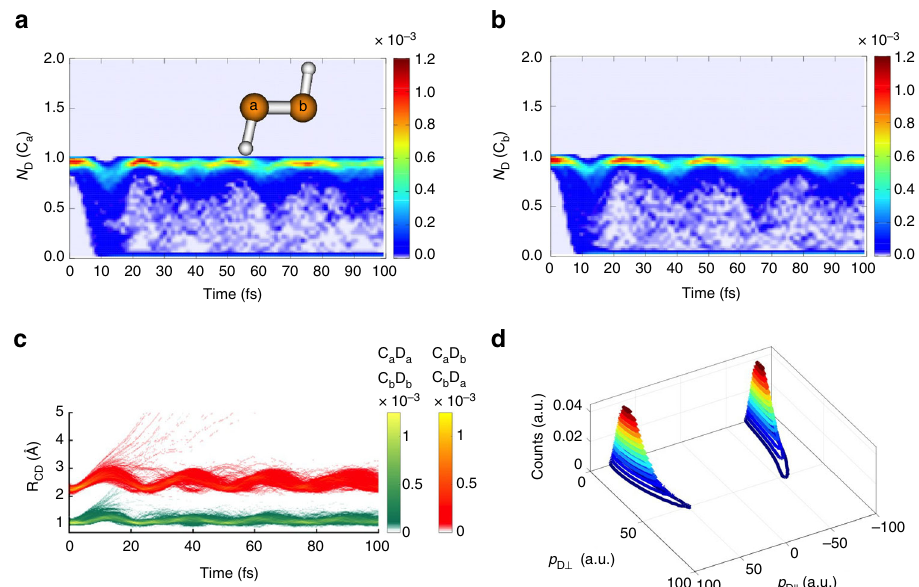
Fig. 3 Dynamics of acetylene dication after Auger decay. Deuteron coordination number ( N D ) of the two carbon atoms a C a and b C b . See main text for de fi nition of the deuteron coordination number. c The C – D distances (R CD ) for the initially bonded C a – D a and C b – D b atoms ( green color ), and for the initially nonbonded C a – D b and C b – D a atoms ( orange color ). d Effective momentum distribution produced from non-dissociating trajectories, assuming no remnant rotation between momentum vectors during the Coulomb explosion. p D ? and p D jj are the components of deuteron momenta that are perpendicular and parallel to the C – C axis,